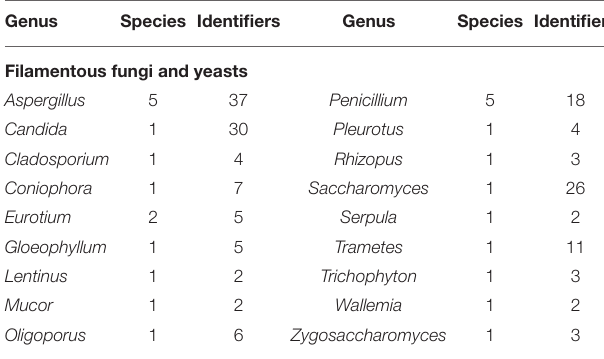
TABLE 3 | The number of filamentous fungi and yeasts species in the WDCM reference strain catalog that have identifier numbers for the reference strains ( WDCM,